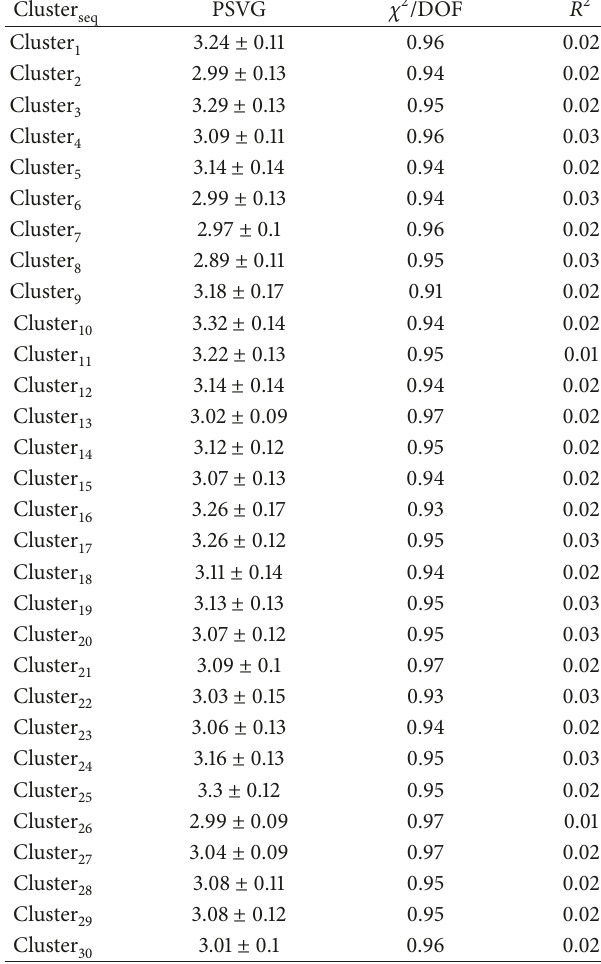
Table 2: List of PSVG values calculated for the visibility graphs constructed from the Monte-Carlo simulated version of the same sample set of 30 cluster data sets (as shown in Table 1) extracted from the visibility graph corresponding to one of the four data sets of 𝜙 -values for 32 S-AgBr (200A GeV) interaction data (constructed in step (1)